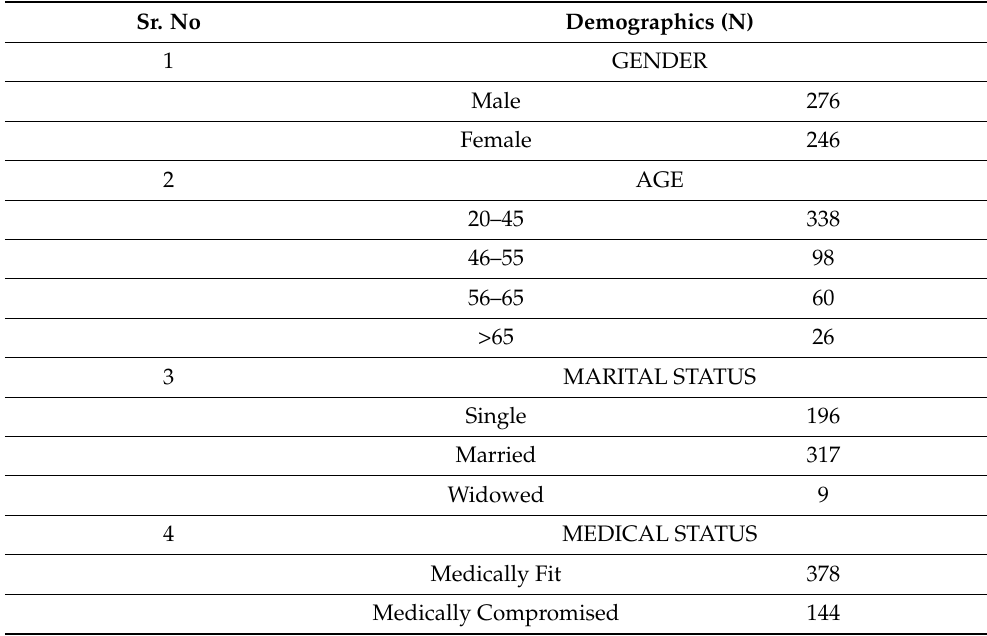
Table 1. Demographics of